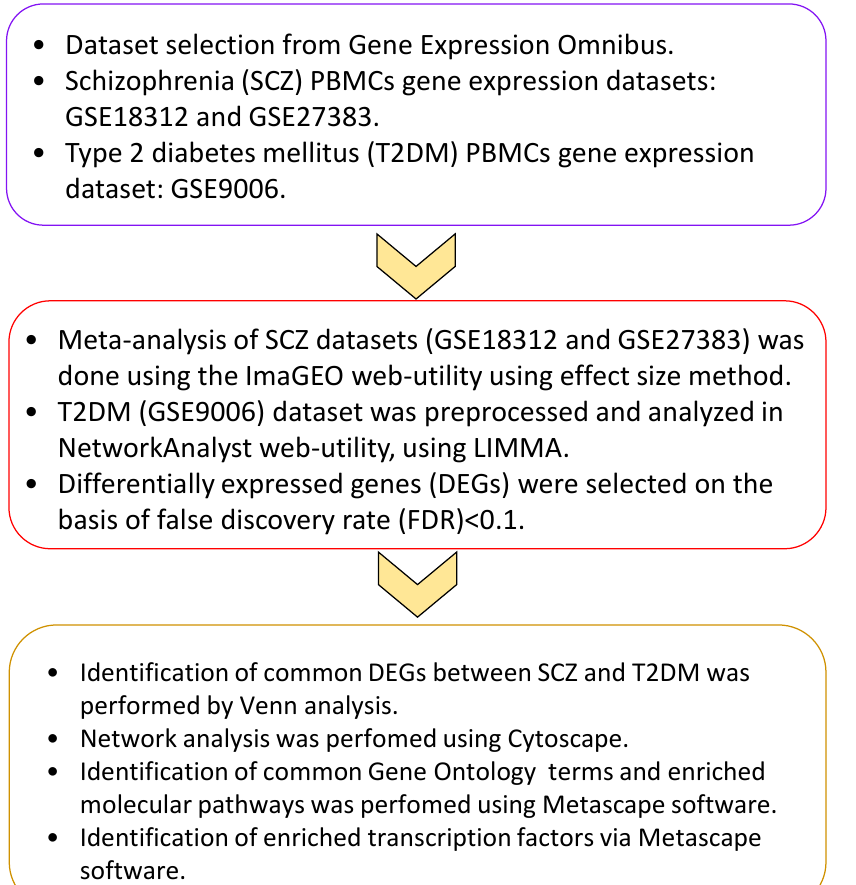
Figure 1. The workflow used in this study.